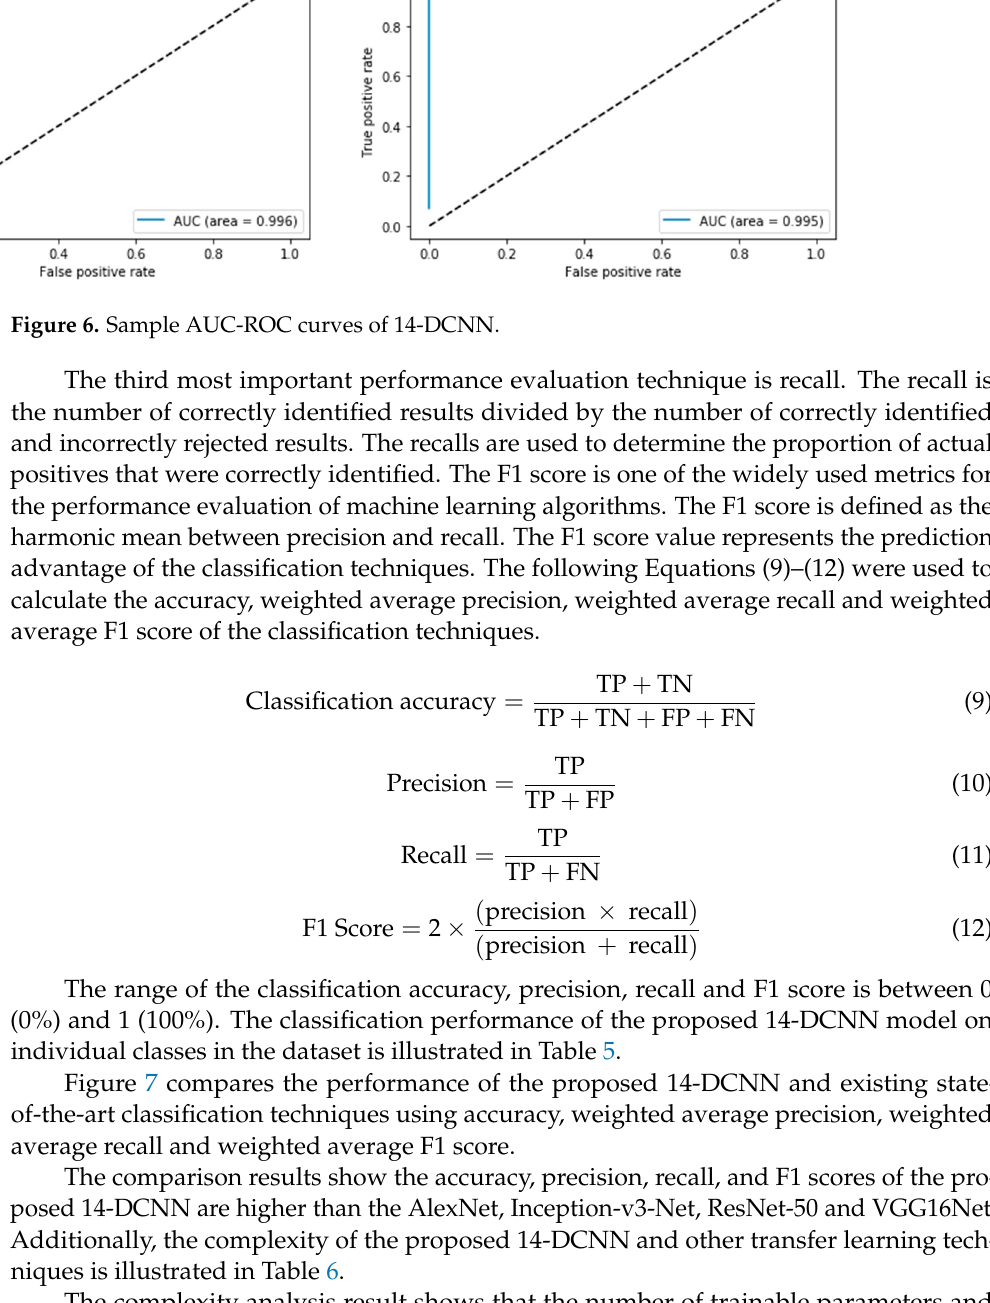
( b ) Figure 5. ( a ) Original image, ( b ) occlusion sensitivity of 14-DCNN. The confusion matrix is a summary of predictions made by the classification tech- niques. The confusion matrix of the classification technique represents the true positive (TP), true negative (TN), false positive (FP) and false negative (FN) values of every single class [3]. The area under the receiver operating characteristic (AUC-ROC) curve is one of the popular metrics that is used to evaluate the performance of learning algorithms. The ROC curve plots the difference between the true positive rate (TPR) and false positive rate (FPR) [15]. The TPR and FPR are calculated using Equations (7) and (8). TPR =